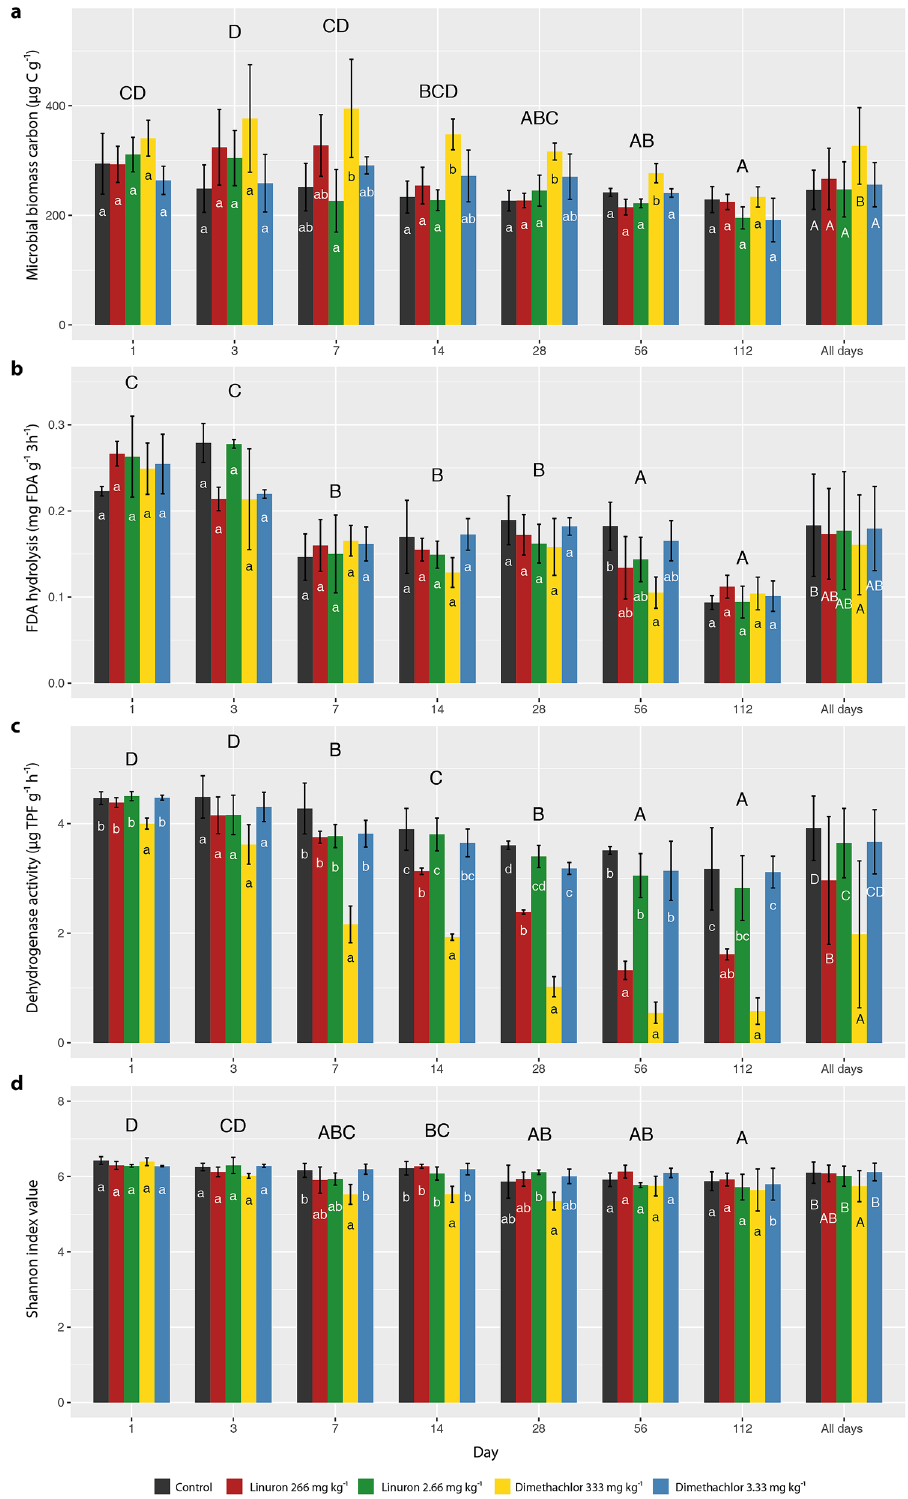
Figure 2. Microbial biomass carbon ( a ), Fluorescein diacetate hydrolysis ( b ) Dehydrogenase activity ( c ), and Shannon index of diversity ( d ) for soil samples treated by herbicides linuron and dimethachlor. Error bars indicate standard deviation. Columns with the same letter are not statistically different at α = 0.05 (Tukey test). Uppercase letters above days and letters in “all days” indicate differences among sampling days and treatment evaluated by two-way ANOVA with interactions. Lowercase letters indicate differences within the same day compared by one-way